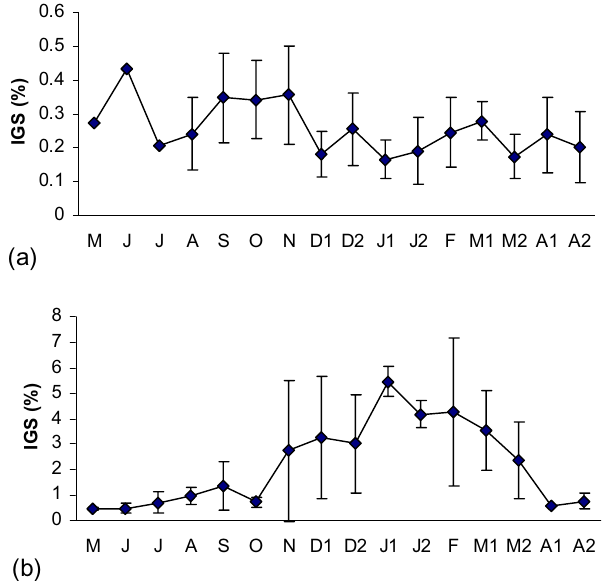
Fig. 3. Monthly variation of mean gonadosomatic index Gymnotus aff. carapo in lagoa Verde, Itapuã State Park, be- tween May/2003 and April/2004. (a) Males, (b) Females. Ver- tical bars are standard deviation from mean.